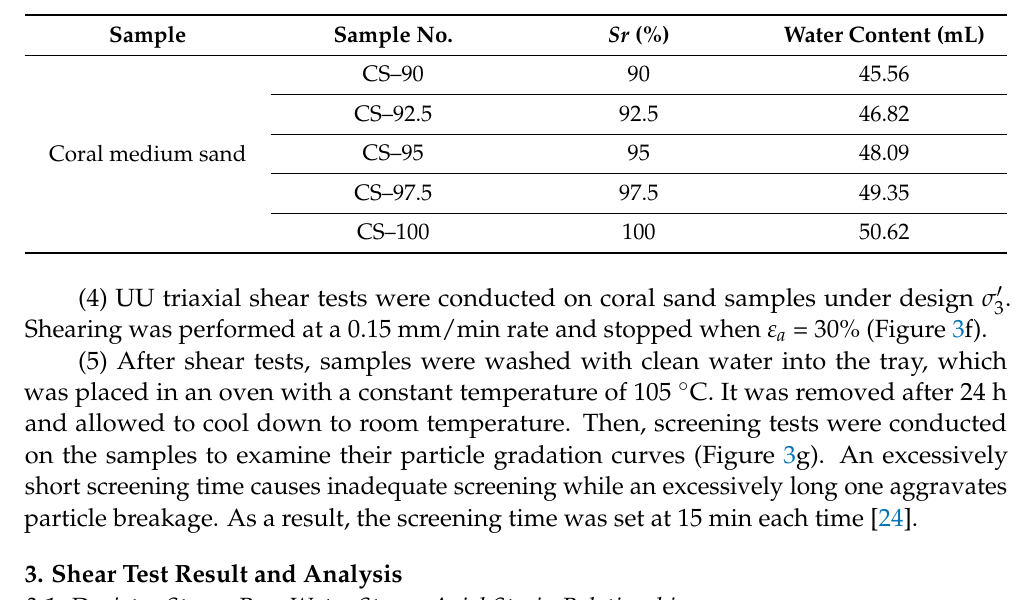
Table 5. Water content of coral sand sample with different